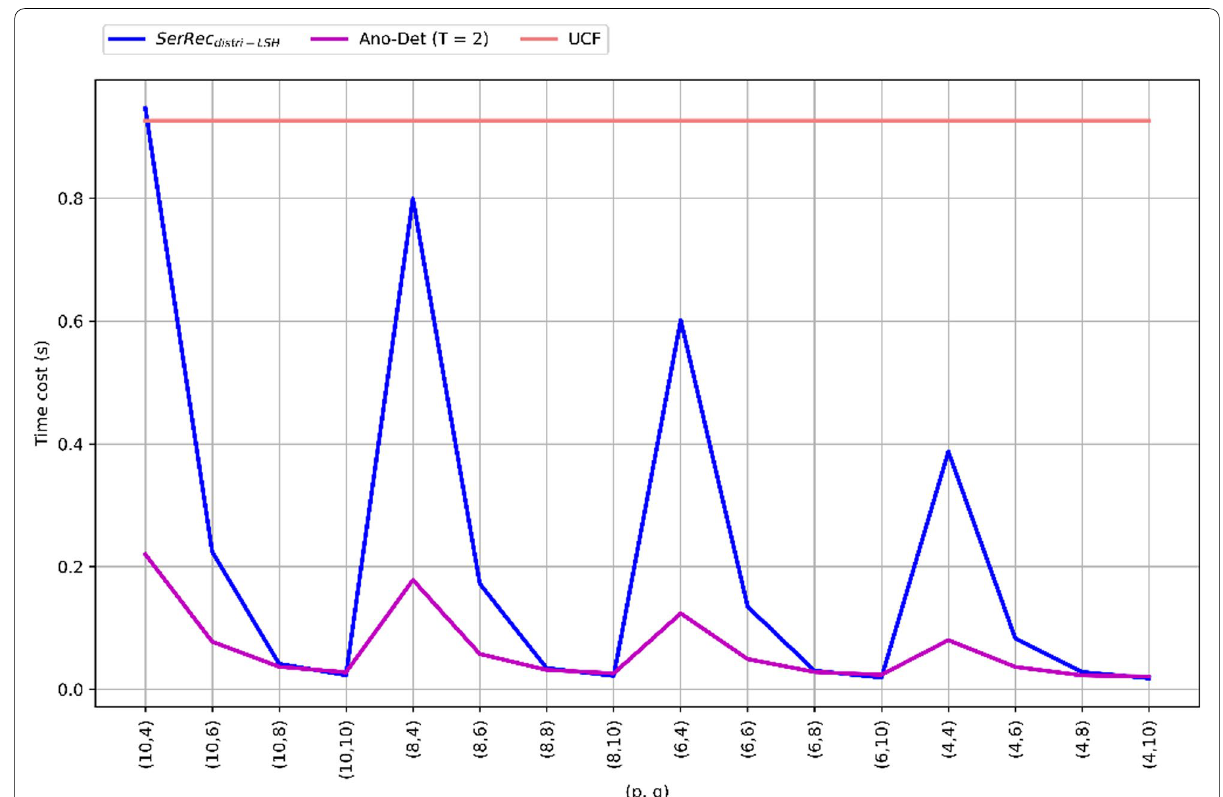
Fig. 3 Anomaly detection efficiency of three